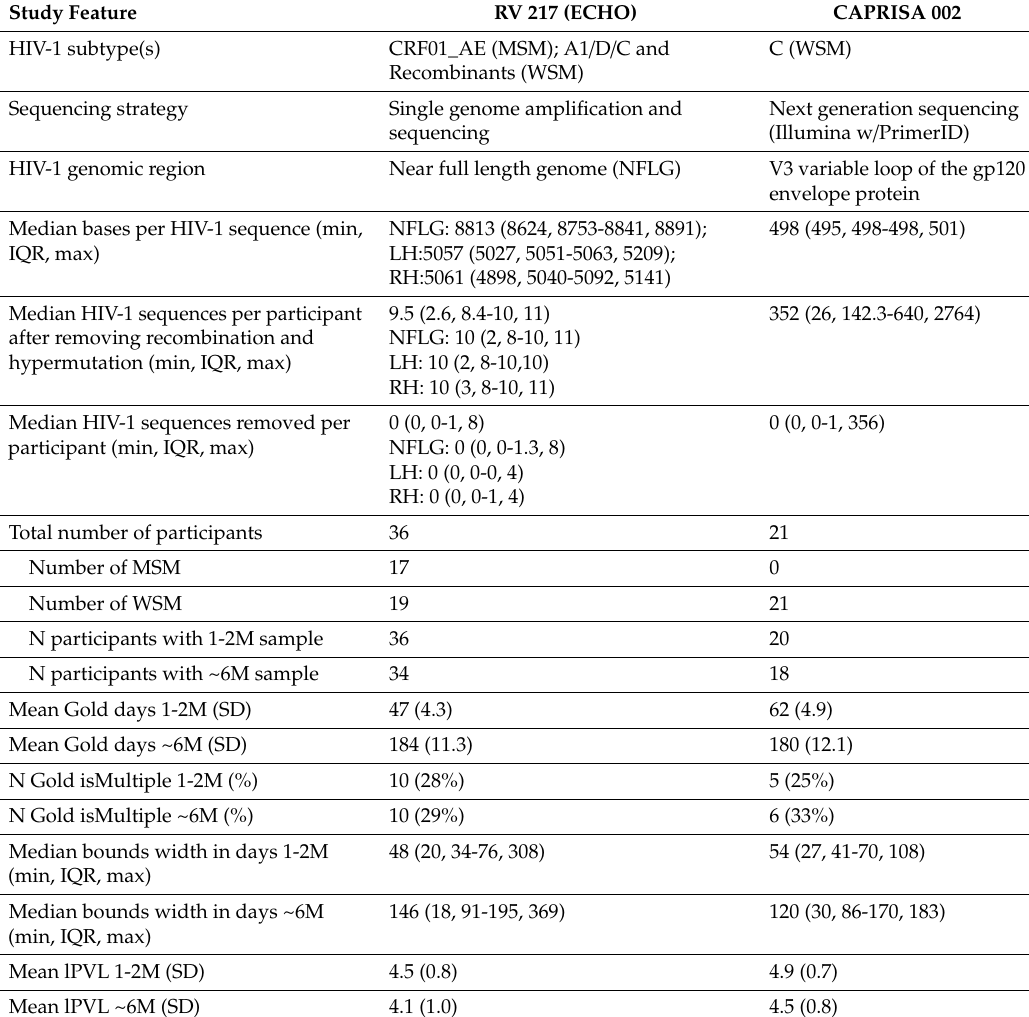
Table 1. Characteristics of HIV-1 sequences and participants in each